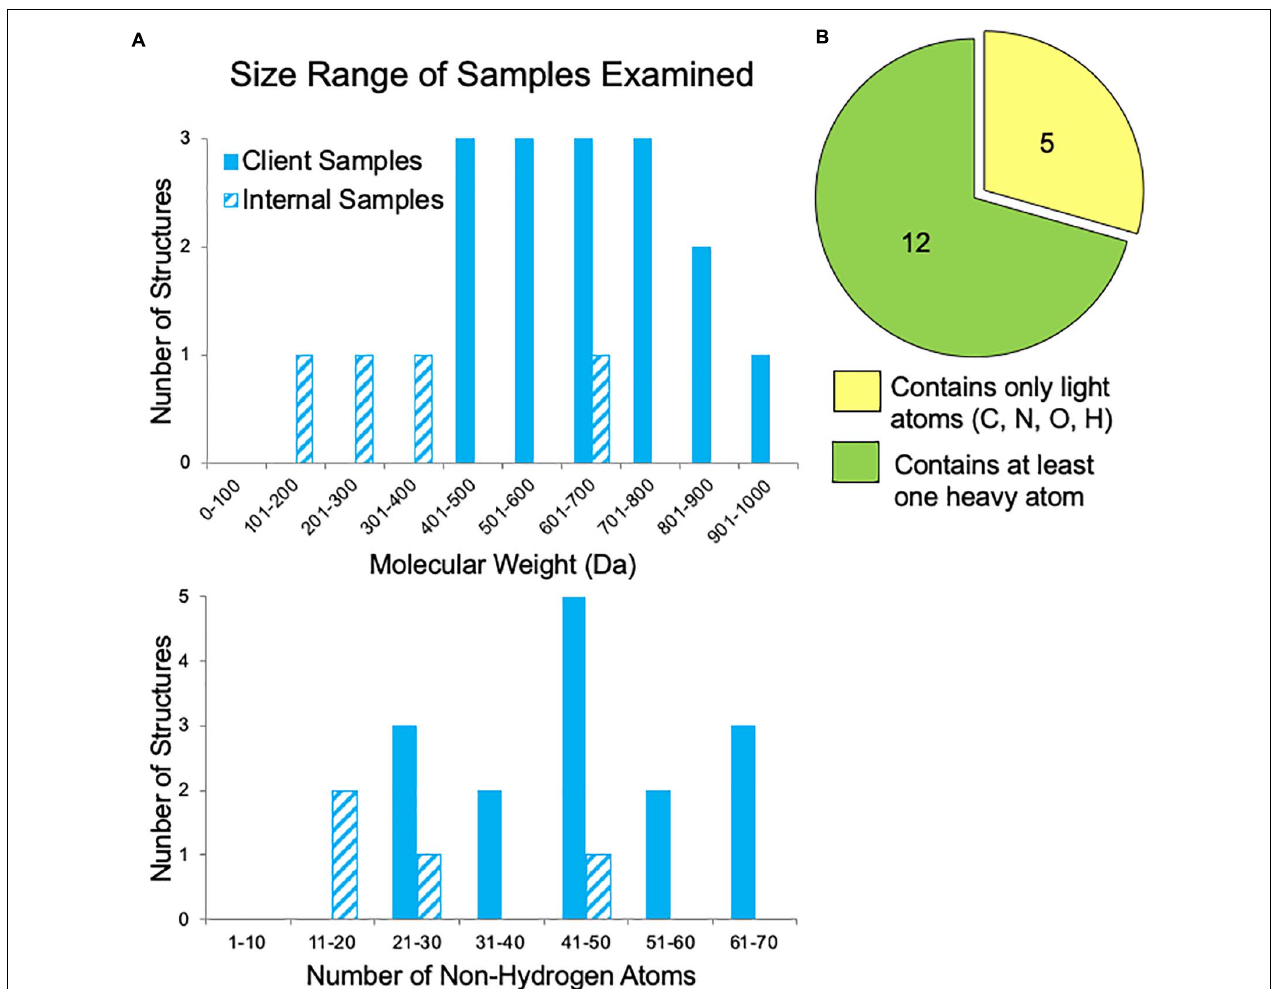
FIGURE 5 | Sample characteristics for internal samples (progesterone, biotin, paracetamol, and teniposide) and a subset of client samples for which these data were known. (A) The range of sample sizes examined in terms of molecular weight and the number of non-hydrogen atoms (e.g., teniposide, C 32 H 32 O 13 S, has 46 non-hydrogen atoms). (B) The distribution of samples containing only light atoms (carbon, nitrogen, oxygen, and/or hydrogen) and those with at least one heavy atom (anything with an element having an atomic number larger than oxygen, such as sulfur, phosphorous, or chlorine), which can make phasing by ab initio methods much